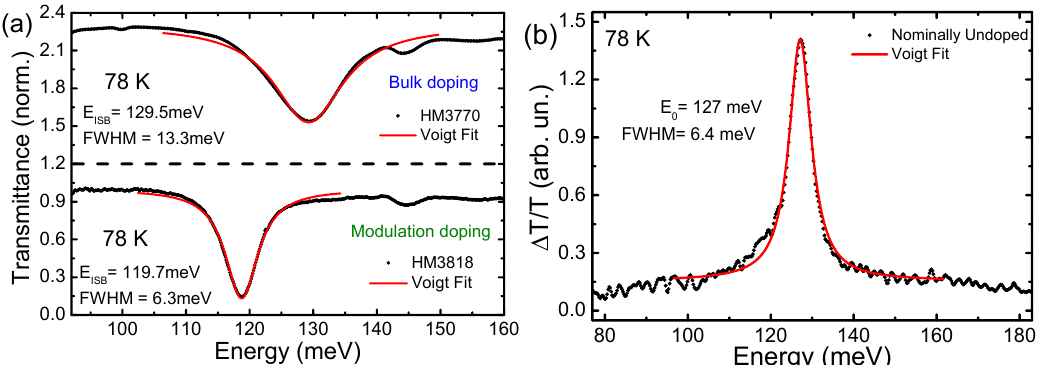
Figure 2. ( a ) Transmittance spectra of the sample doped within the well (upper panel) and the modulation doped sample at 78 K (lower panel). The red curves are the Voigt fitting functions. ( b ) The photo-induced absorption spectrum of the nominally undoped sample at 78 K with its Voigt fit